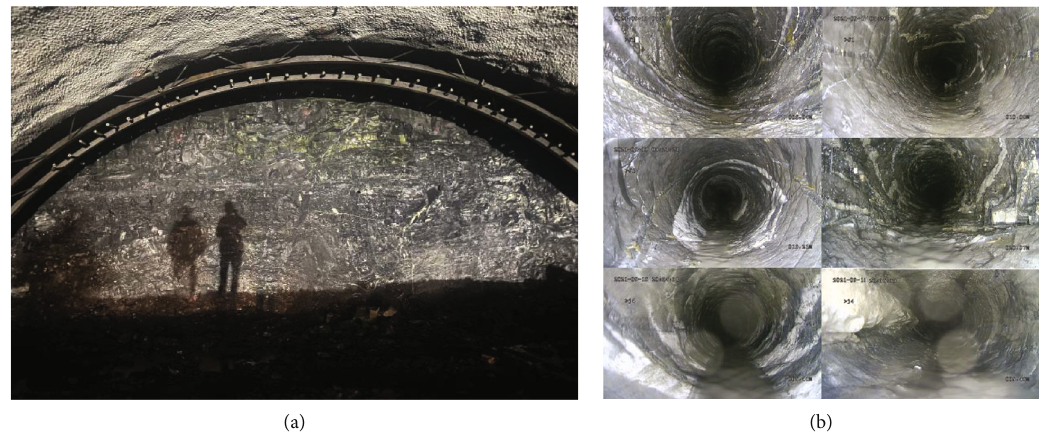
Figure 15: Grouting e ff ect: (a) palm surface after grouting and (b) in-hole imaging of the inspection hole after